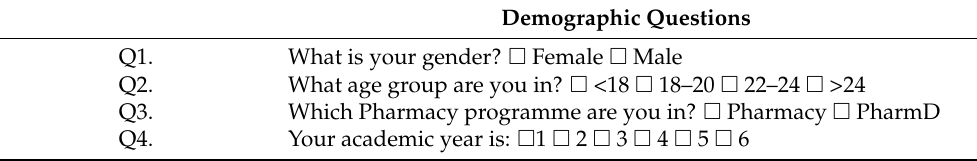
Table 2. Survey demographics questions.